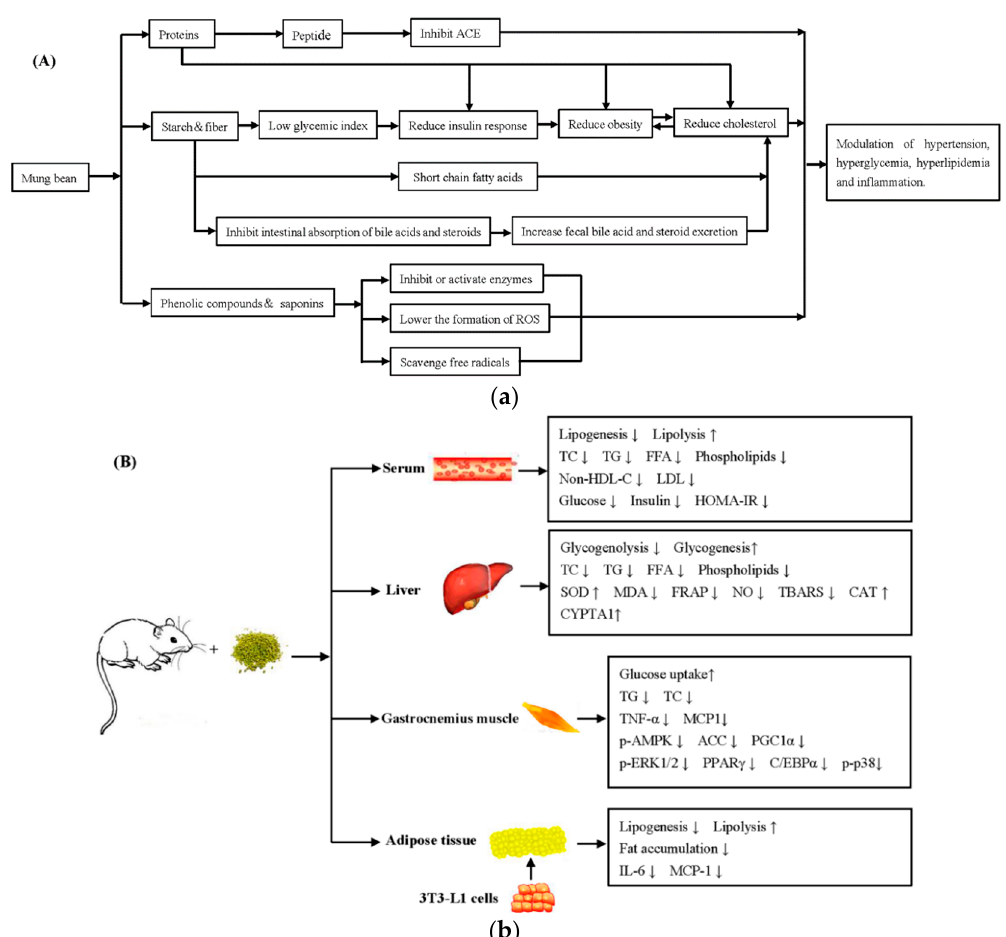
Figure 2. ( A ) Modulation of hypertension, hyperglycemia, and hyperlipidemia and inflammation by the mung bean (including seeds, sprouts, and seed coats) or its active components. ( B ) Schematic diagram depicting the beneficial effects of the mung bean (including seeds, sprouts, and seed coats) or its active components on metabolic responses. The mung bean or its active compounds prevented an increase in serum glucose and lipid concentrations by inhibiting the activities of the related enzymes in a carbohydrate and lipid metabolism, increasing lipolysis in the liver and adipose tissue and decreasing oxidative stress in white adipose tissue, also increasing capacity of energy metabolism in the gastrocnemius muscle. In addition, the expression levels of inflammation-related genes in the liver, muscle, and adipose tissue were inhibited. The mung bean protein was hydrolyzed into peptides with small molecular weight to reduce the blood pressure. ↑ and ↓ sign, after the mung bean or the supplementation of its active compounds, represented an increase and decrease, respectively. (Original).